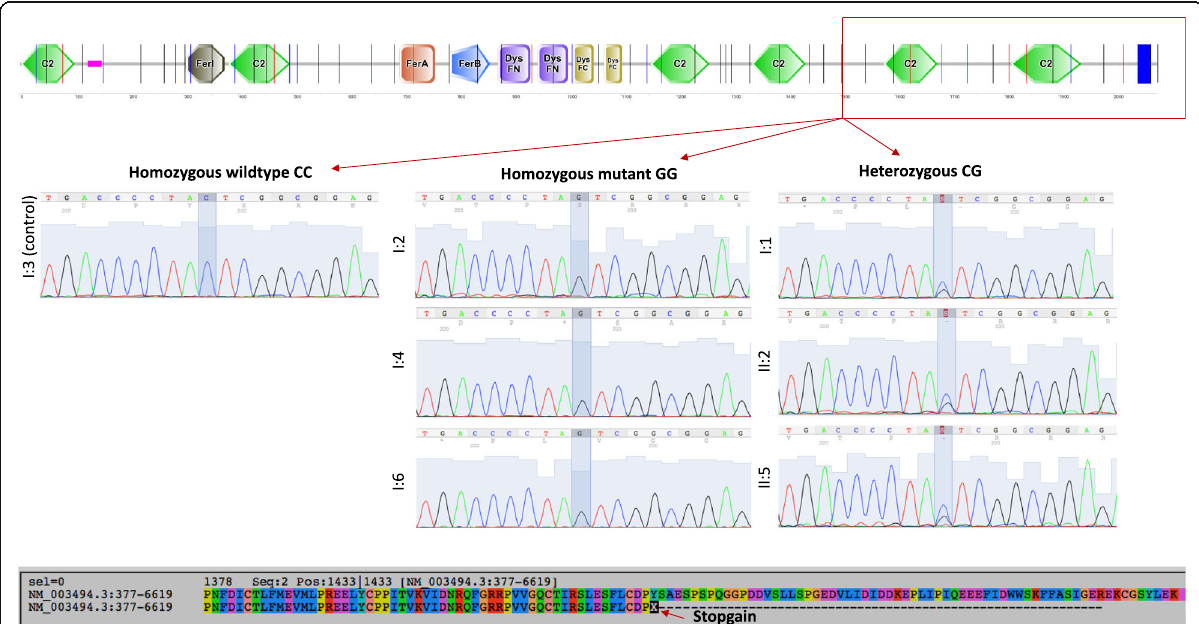
Fig. 2 Protein level consequence of the identified novel stop-gain dysferlin gene ( DYSF ) mutation. The diagram illustrates the loss of two C2 domains in DYSF gene due to the identified novel stop-gain. The chromatogram illustrates the Sanger sequencing validation for mutant and wild-type alleles in the affected and unaffected family members. The protein alignment illustrates the nonsense mutation and protein